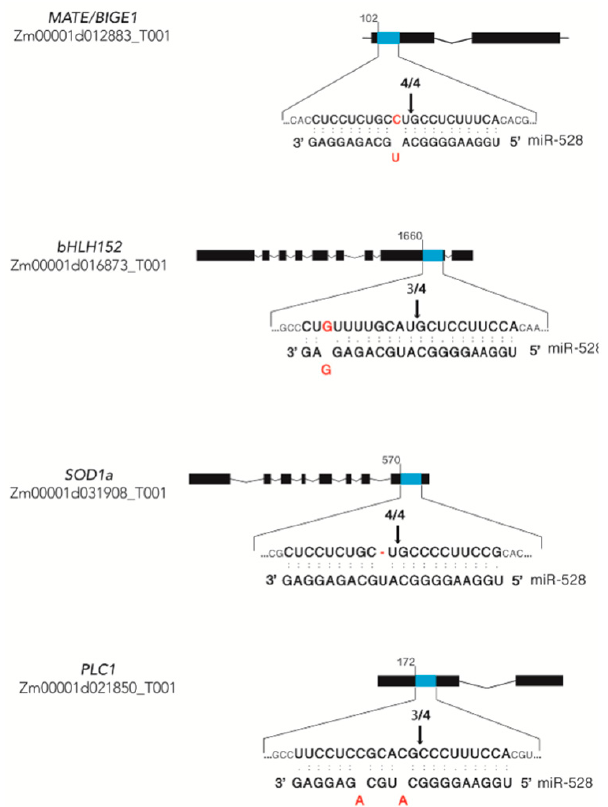
Figure 2. Experimentally validated cleavage sites for zma-miR528 targets. Validation for cleavage was obtained after 5 ′ -RLM-RACE mapping, as described in the methods. The presence of cleavage products is shown in Supplementary Material, Figure S1. Arrows designate the cleavage sites, and the above numbers indicate the proportion of clones showing the same site. The upper strand represents the targets with the complementary site (blue-filled fragment), and the bottom strand shows the pairing with the miRNA sequence. Mismatches are shown in red. (:) pairing, (.) non-canonical pairing.